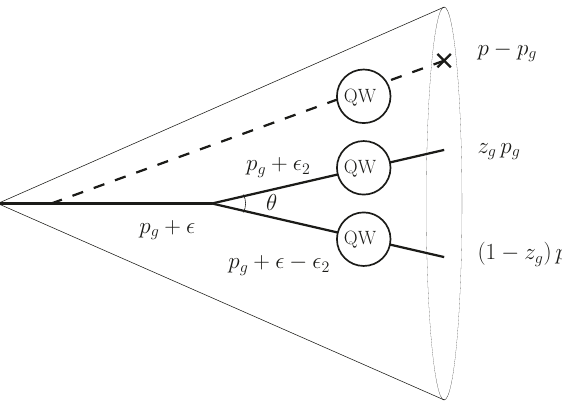
Figure 4. Illustration of the splitting function in the incoherent